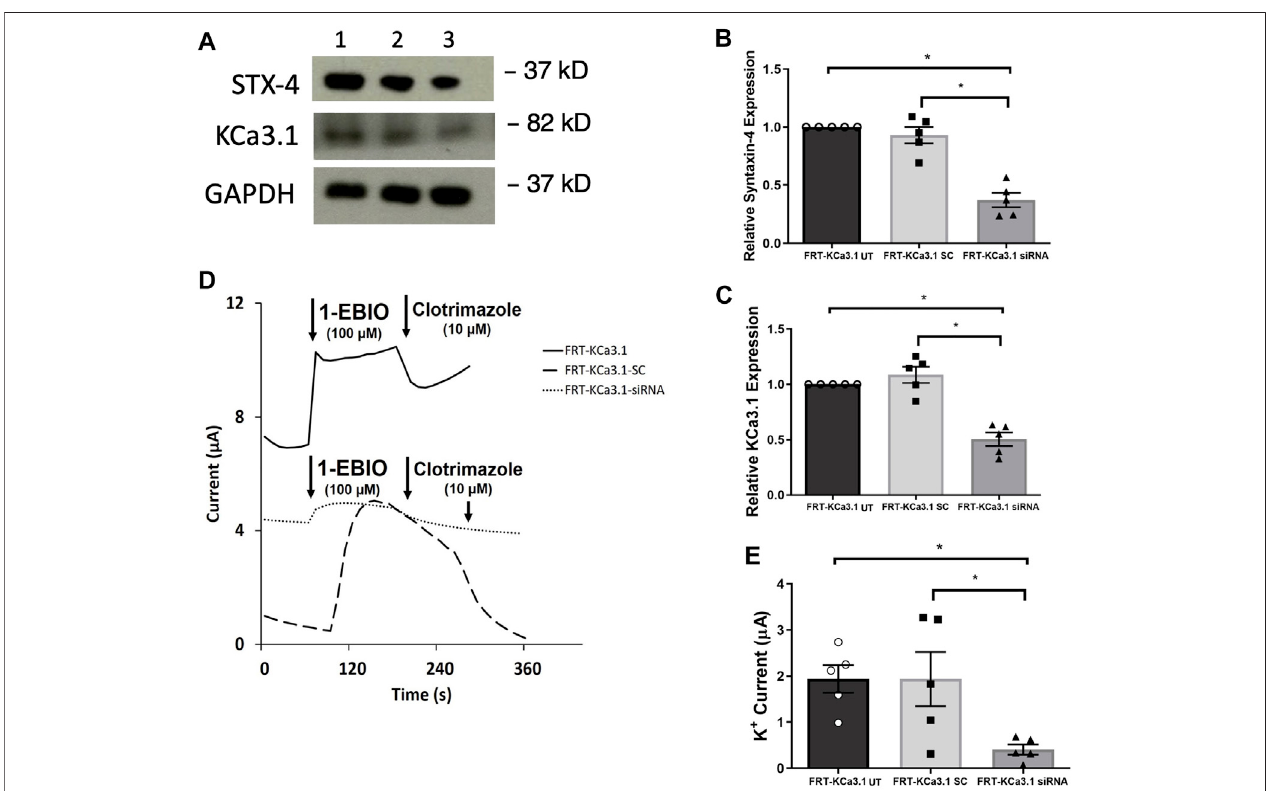
FIGURE 4 | The membrane expression and function of KCa3.1 in response to the siRNA knockdown of STX-4. FRT-KCa3.1-BLAP cells were reverse transfected (20 pM, 48 h) witha scrambled siRNA (FRT-KCa3.1-SC) orsiRNA toknock down STX-4(FRT-KCa3.1-siRNA). (A) FRT-KCa3.1 UT (untransfected with any siRNA, UT), FRT-KCa3.1-SC, and FRT-KCa3.1-siRNA cells were run by immunoblot (8% gel). Lanes were loaded with 30 μ g of protein. STX-4 and KCa3.1 were detected in FRT- KCa3.1 cells. Lane 1: FRT-KCa3.1, Lane 2: FRT-KCa3.1-SC, and Lane 3: FRT-KCa3.1-siRNA. GAPDH was used as a loading control. (B) STX-4 expression in FRT-KCa3.1-siRNA cells was reduced by 60 ± 6% ( n = 5, * p ≤ 0.05) with respect to FRT-KCa3.1-SC cells. (C) In the presence of knockdown of STX-4, the KCa3.1 membrane expression in FRT-KCa3.1-siRNA cells was reduced by 54 ± 6% ( n = 5, * p ≤ 0.05) with respect to FRT-KCa3.1-SC cells. (D) Ussing chamber experiment of FRT-KCa3.1 cells with STX-4 knock down. Representative traces of control FRT-KCa3.1 (black line), FRT-KCa3.1-SC cells (dashed line) and FRT-KCa3.1-siRNA cells (dotted line) are shown. 1-EBIO promoted a signi fi cantly reduced K + current in the FRT-KCa3.1-siRNA cells compared to control FRT-KCa3.1 or the FRT-KCa3.1-SC control cells. This current was abated by clotrimazole (10 µM). (E) Bar graph of K + current of control FRT-KCa3.1 UT, FRT-KCa3.1-SC control and FRT-KCa3.1-siRNA cells treated with 1-EBIO. FRT-KCa3.1-siRNA cells demonstrated a signi fi cantly reduced current by 78 ± 11% ( n = 5, * p ≤ 0.05) compared to FRT-KCa3.1-SC cells.